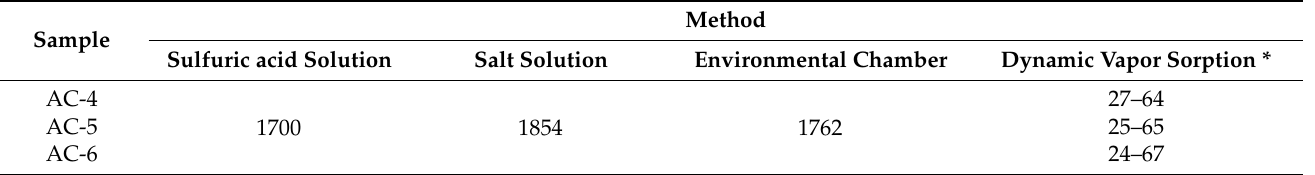
Table 10. Total time duration of the